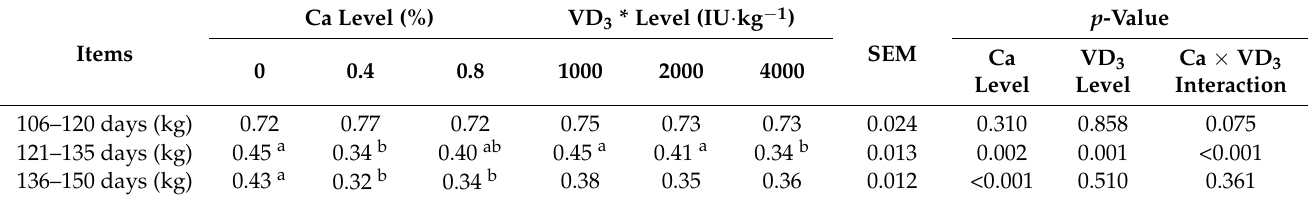
Table 2. The outcome of Ca and VD 3 diet supplementation on ADG of maturing and furring blue foxes.